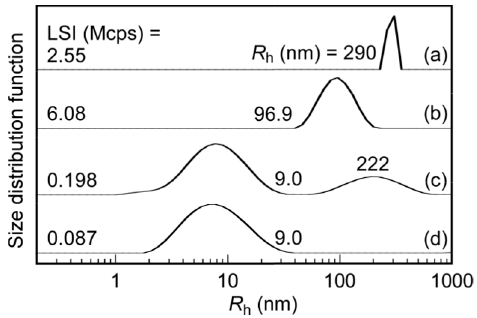
Figure 6. Hydrodynamic radius ( R h ) distributions for ( a ) PMEA, ( b ) P(MEA / MPC 6 ), ( c ) P(MEA / MPC 12 ), and ( d ) P(MEA / MPC 46 ) in pure water at C p = 1.0 g / L at 25 ◦C.